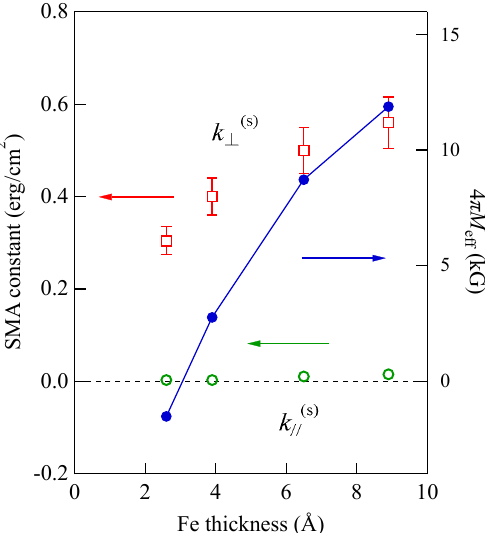
( ) ( ) ( s ) □ ) and k ( s ) s k s k ( # ) and 4 π M eff ( • ) for four Fe thicknesses. The solid ⊥ ( ( ○ ) and 4 π M eff ( • ) for four Fe thicknesses. // ⊥ ( □ ) and //